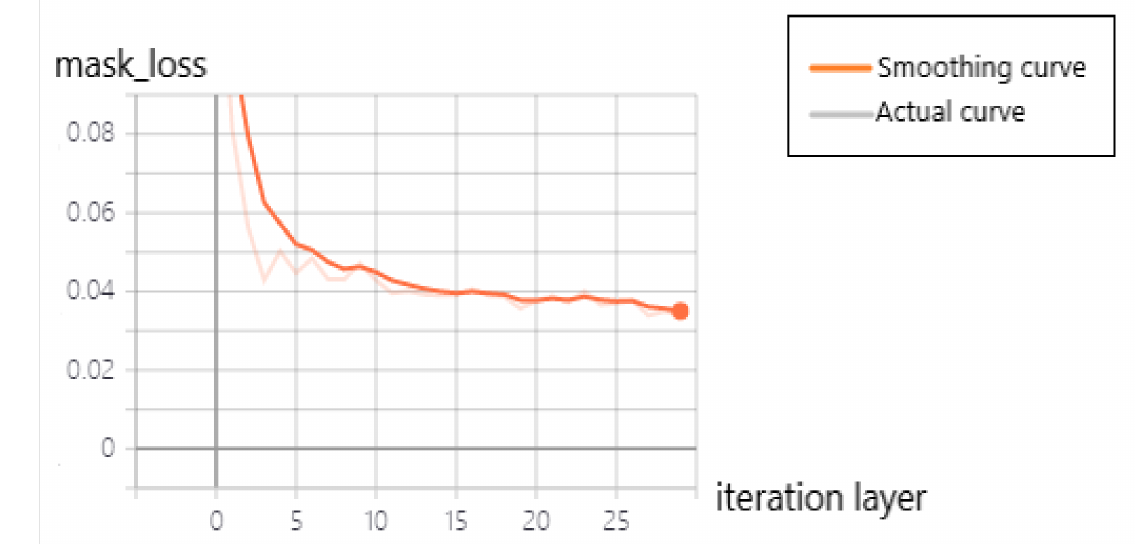
Figure 24. Mask loss of Mask R-CNN 3.